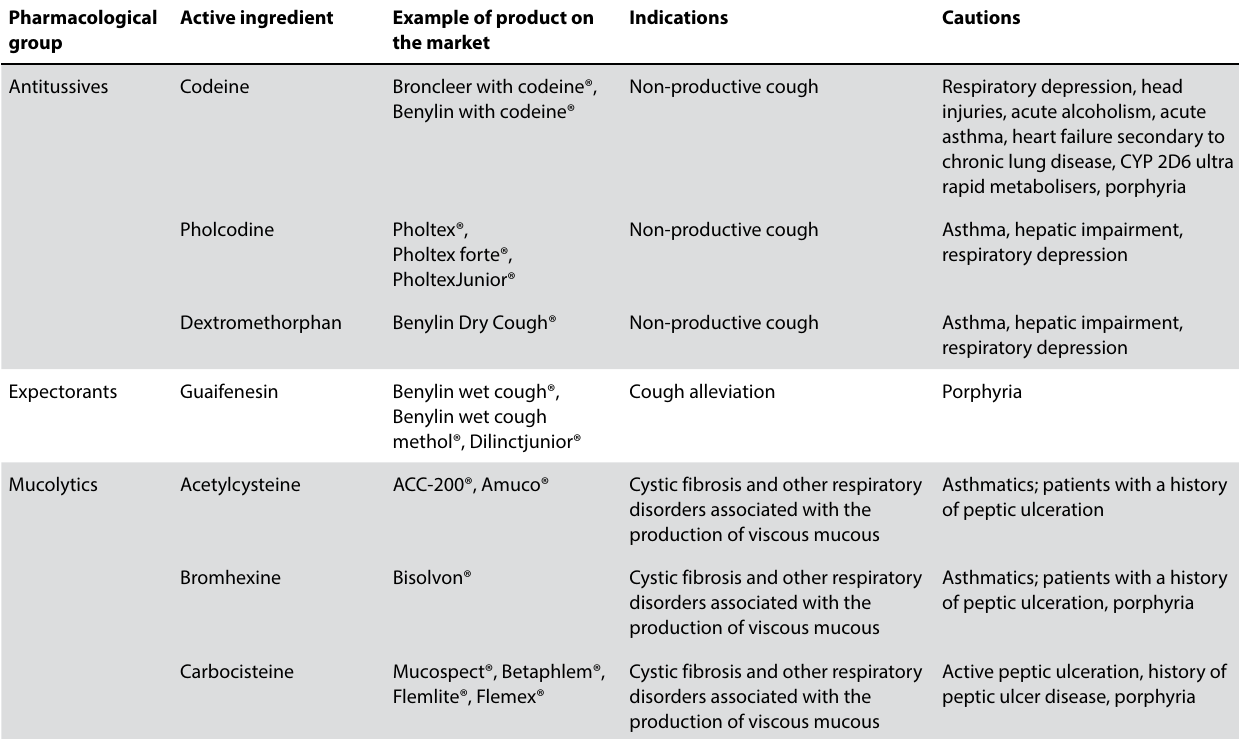
Table 3: Examples of over the counter (OTC) preparations available in South Africa 29